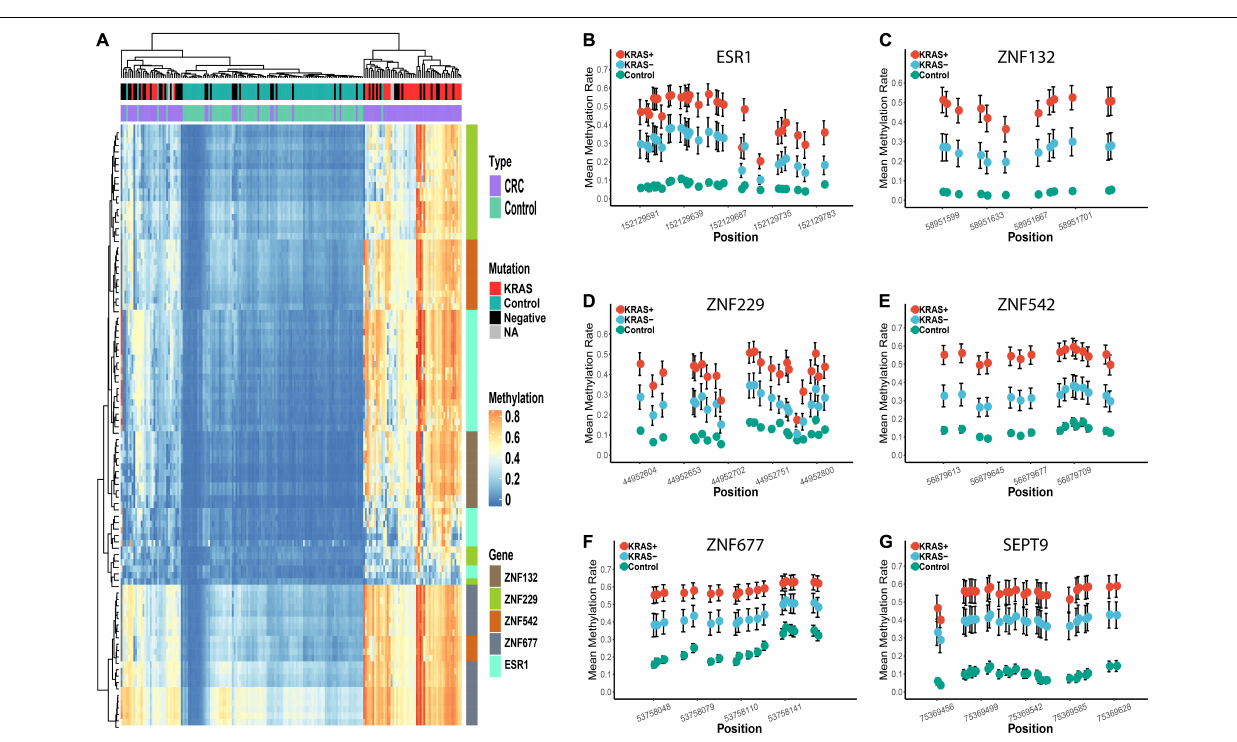
Frontiers in Cell and Developmental Biology |